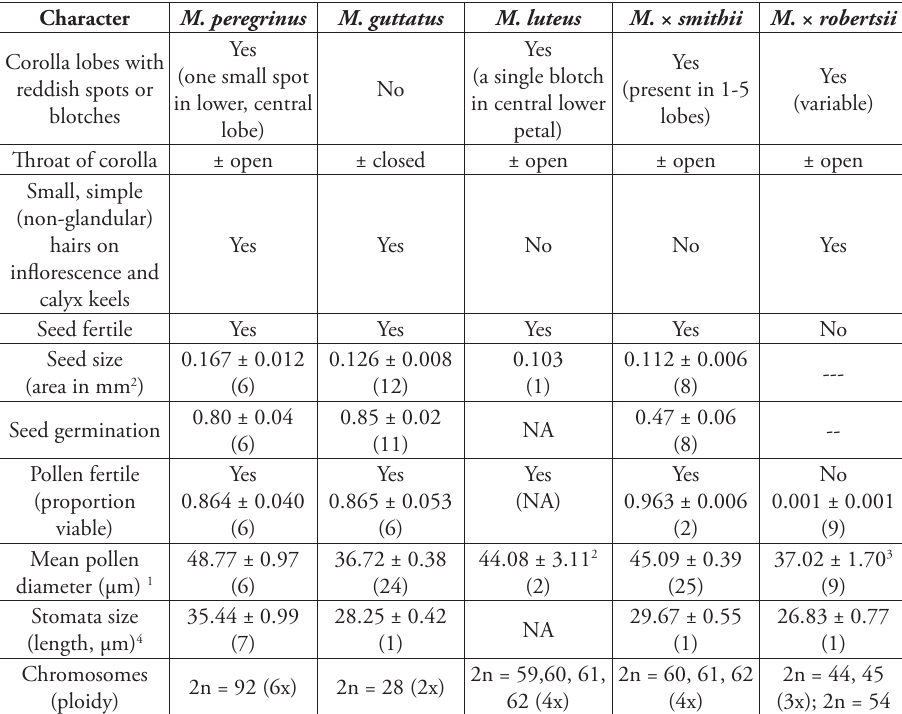
1 = Measured in pollen preserved in 70% ethanol and dyed with lactophenol-aniline blue. 2 = Measured in pollen preserved in Hoyer’s medium and dyed with lactophenol-aniline blue. 3 = Inviable (empty) pollen grains are variable in size as they may be fully expanded or partly collapsed. 4 = Measured in 20 stomata per